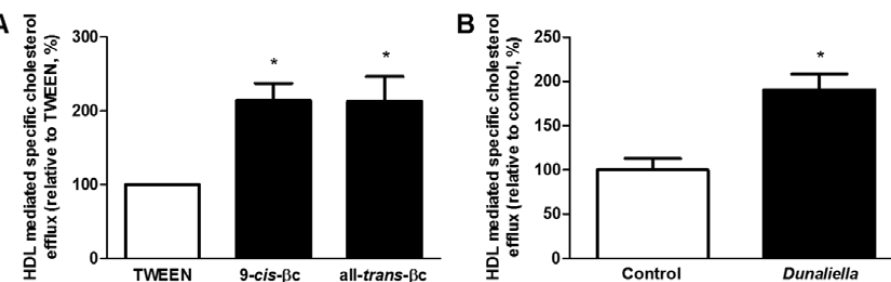
Figure 4. 9- cis - βc increased macrophage cholesterol efflux to HDL. ( A ) RAW264.7 macrophages were treated for 24 h with vehicle (TWEEN 40), 2 µM of 9- cis - βc or all - trans - βc. Cells were labeled with serum-free DMEM containing 0.5 µCi/mL 3 H-cholesterol for 6 h. Cholesterol efflux was determined after 0.5-h incubation with 1 µg/mL HDL, relative to TWEEN (2% efflux). The results are expressed as mean ˘ SE of five independent experiments, each preformed in triplicate. * p < 0.05; ( B ) Peritoneal macrophages isolated from LDLR–/– mice fed chow diet fortified with ( n = 5) or without ( n = 5) Dunaliella for four weeks. Cells were labeled with serum-free DMEM containing 0.5 µ Ci/mL